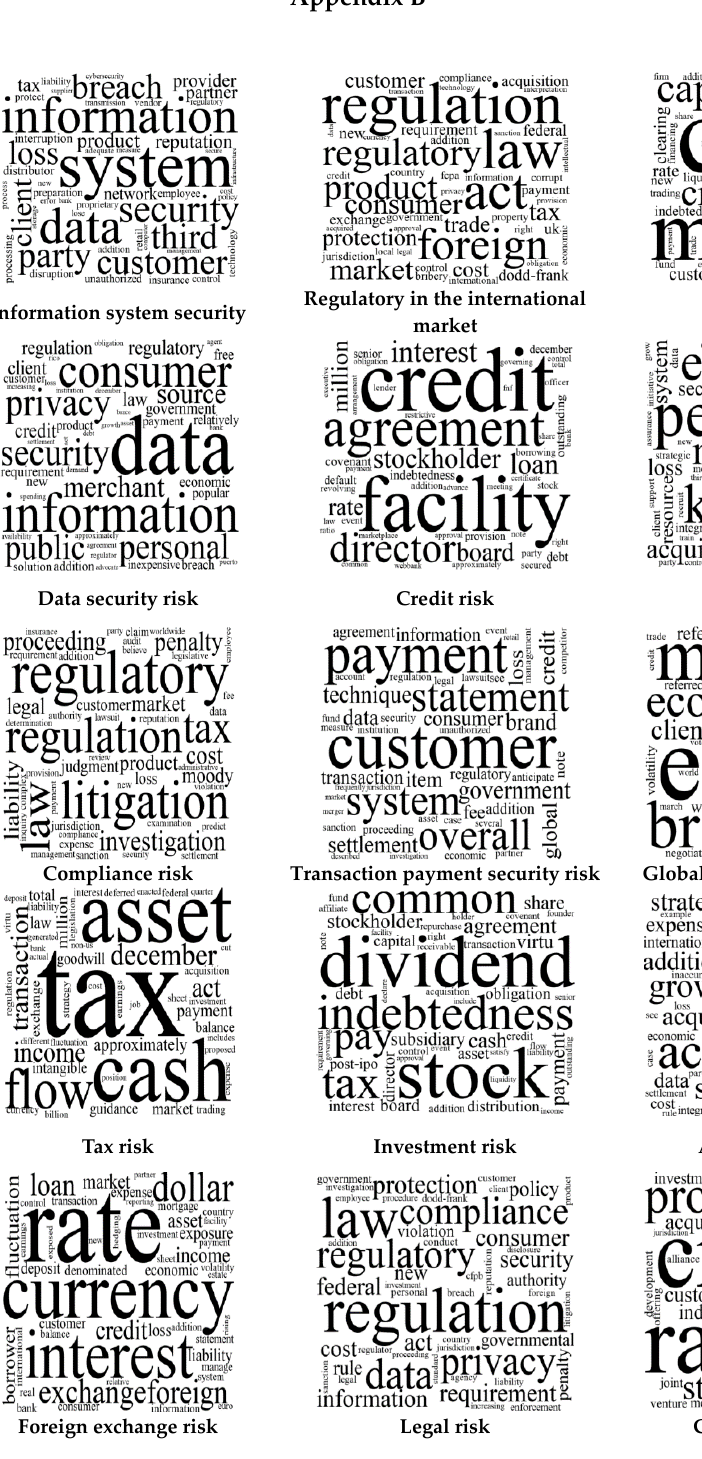
Figure A1. The word clouds of the identified 20 fintech risk factors.